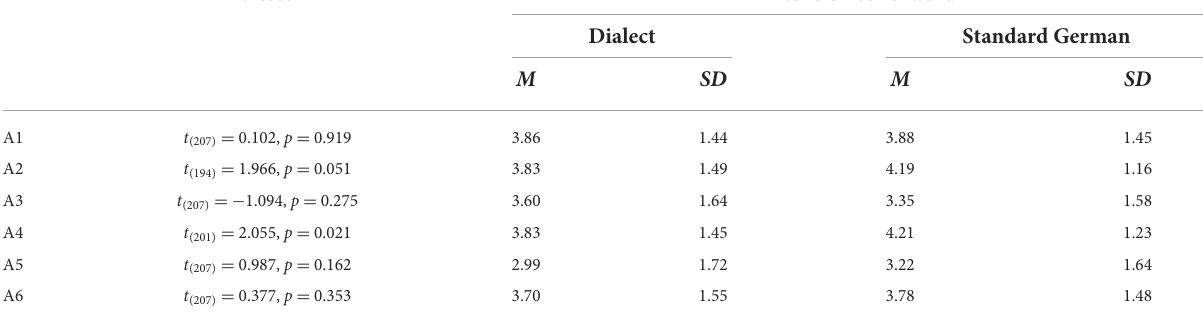
TABLE 1 Differences in the intention to forward the image macro adaptations in study